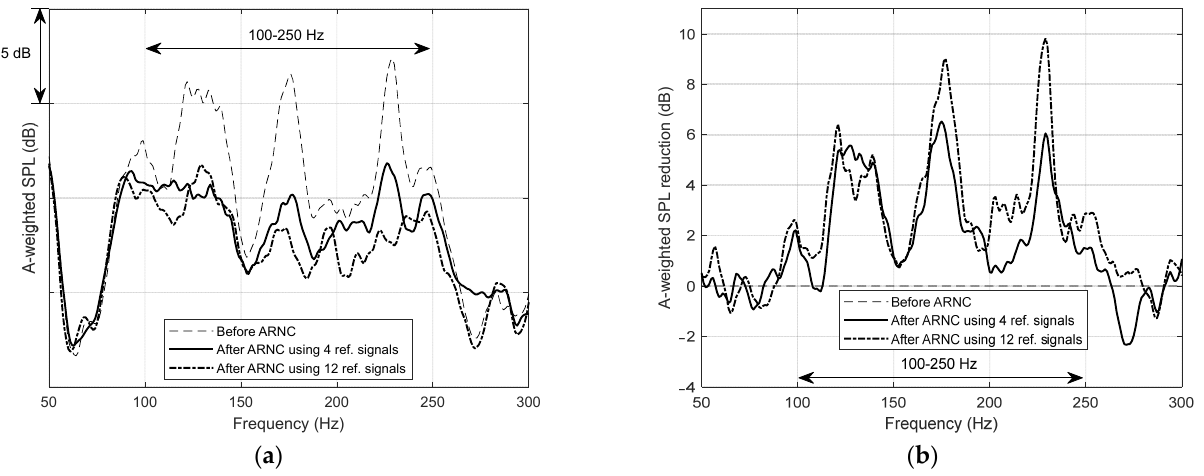
Figure 9. Comparisons of the measured A-weighted SPLs before control (thin dashed lines), after controls with the 4 reference signals (thick solid lines) or the 12 reference signals (thick dotted-dashed lines), and their reductions with respect to the frequency. ( a ) A-weighted SPLs. ( b ) A-weighted SPL reductions.